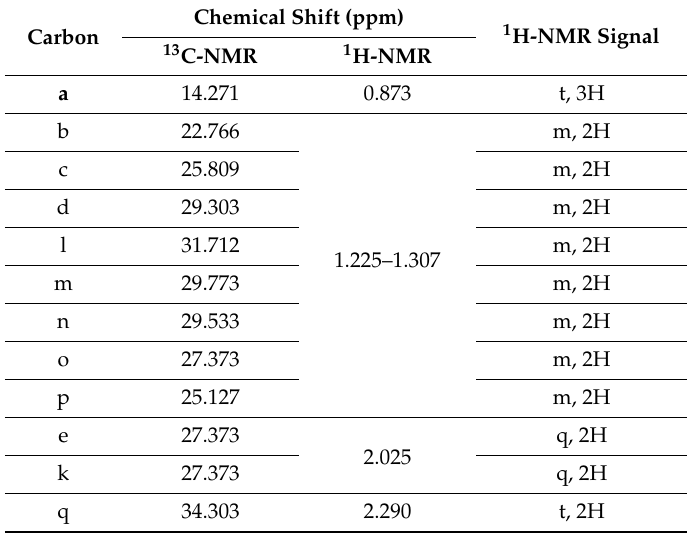
Table 1. 2D-heteronuclear multiple quantum coherence (HMQC) correlation of 13 C nuclear magnetic resonance (NMR) and 1 H-NMR signals for pyrogallol